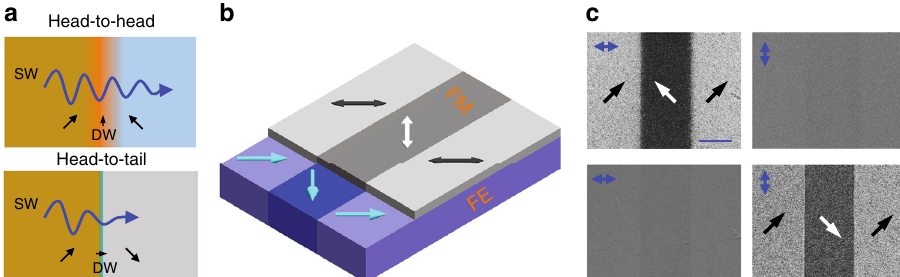
Fig. 1 Spin-wave control via programming of pinned magnetic domain walls. a Schematic of spin-wave (SW) transmission through a pinned 90° magnetic domain wall (DW) with a head-to-head and head-to-tail structure. The pinned domain wall in the ferromagnetic fi lm separates stripe domains with uniaxial magnetic anisotropy. Because the anisotropy axis rotates by 90° at the domain boundary, a magnetic fi eld along the boundary initializes a head-to-head (top) or tail-to-tail wall. These domain walls are broad and transparent to spin waves. Application of a magnetic fi eld perpendicular to the boundary results in the formation of a much narrower head-to-tail domain wall (bottom). Spin waves are mostly re fl ected by this wall. Reversible magnetic switching of the domain-wall structure thus actively alters the transmission of spin waves. b Illustration of the experimental CoFeB/BaTiO 3 bilayer system. The domain pattern of the ferroelectric (FE) substrate is imprinted into the ferromagnetic (FM) fi lm via strain transfer and inverse magnetostriction. Blue arrows and double-headed black and white arrows indicate the direction of ferroelectric polarization and the orientation of uniaxial magnetic anisotropy. c Magneto- optical Kerr microscopy images of the magnetization con fi guration in a CoFeB/BaTiO 3 bilayer after the application of a magnetic fi eld along the domain boundaries (top) and perpendicular to the domain boundaries (bottom). The left and right images are taken with the magneto-optical contrast axis along the horizontal and vertical direction, respectively (blue arrows). The blue scale bar corresponds to 10 μ